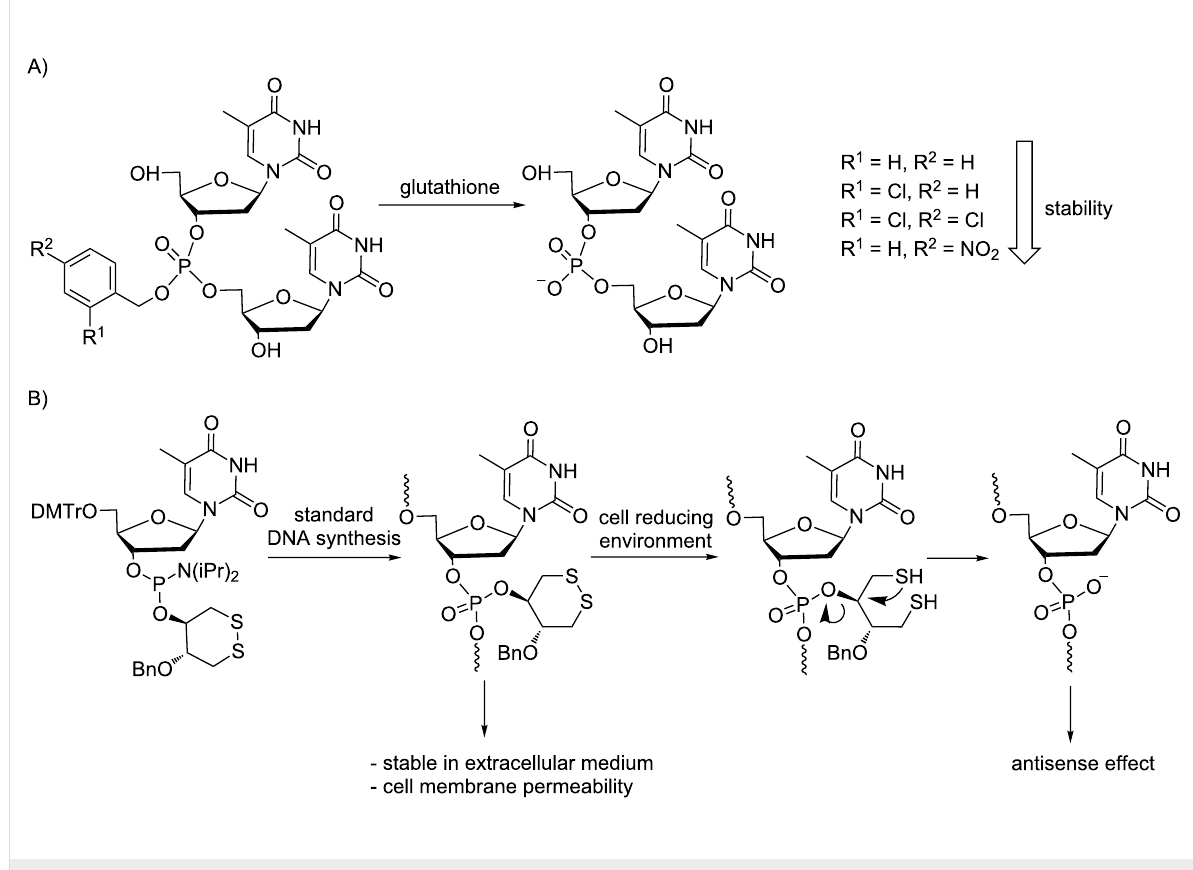
Scheme 1: Demasking under reducing agents of ON prodrugs modified as phosphotriesters with A) benzyl groups [13] and B) a cyclic disulfide trans -5-benzyl-1,2-dithiane-4-yl moiety